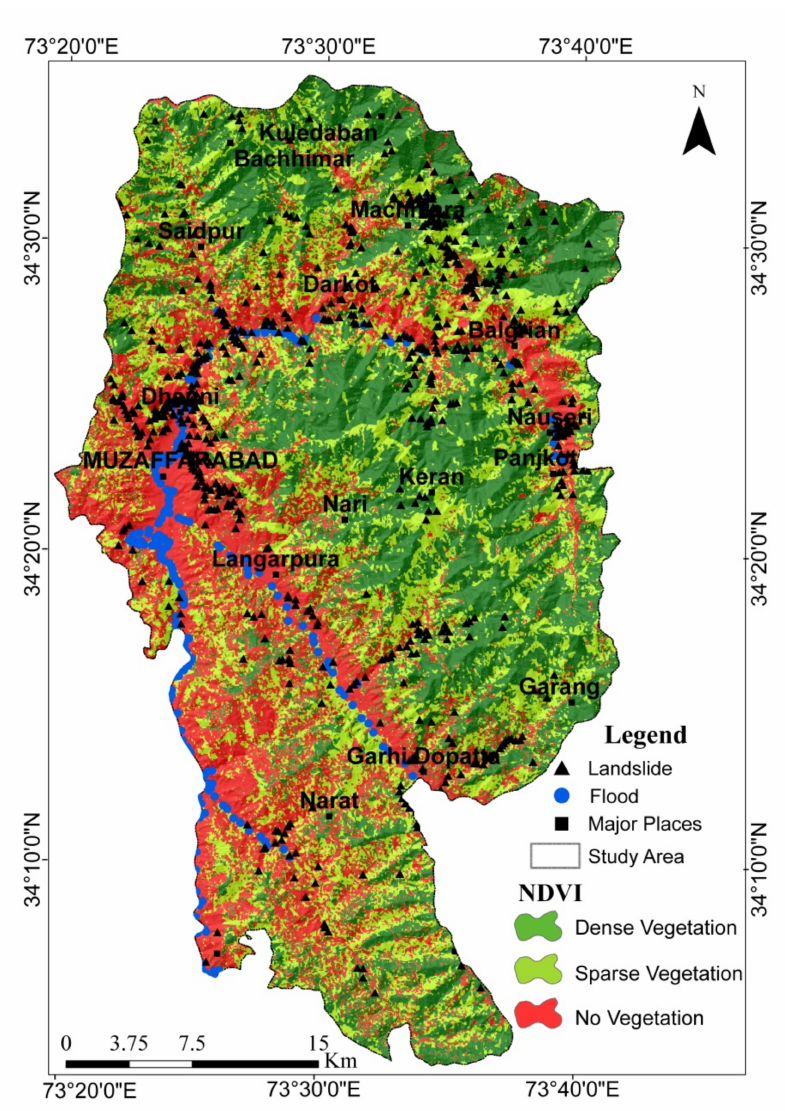
Figure 12. NDVI causative factor